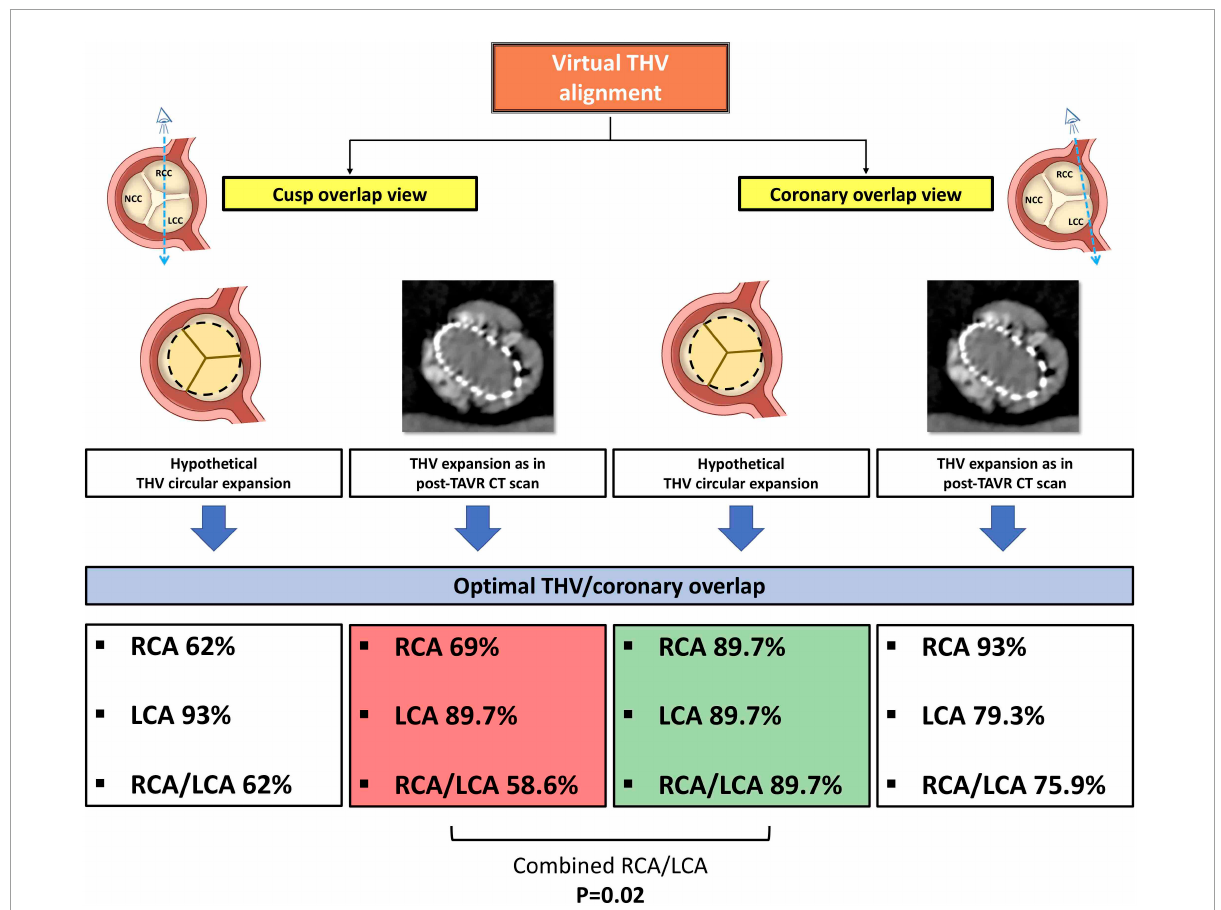
FIGURE5 Illustration of the virtual THV alignment simulation with rates of optimal THV/coronary overlap. See the description in the main text. THV, transcatheter heart valve; RCA, right coronary artery; LCA, left coronary artery.